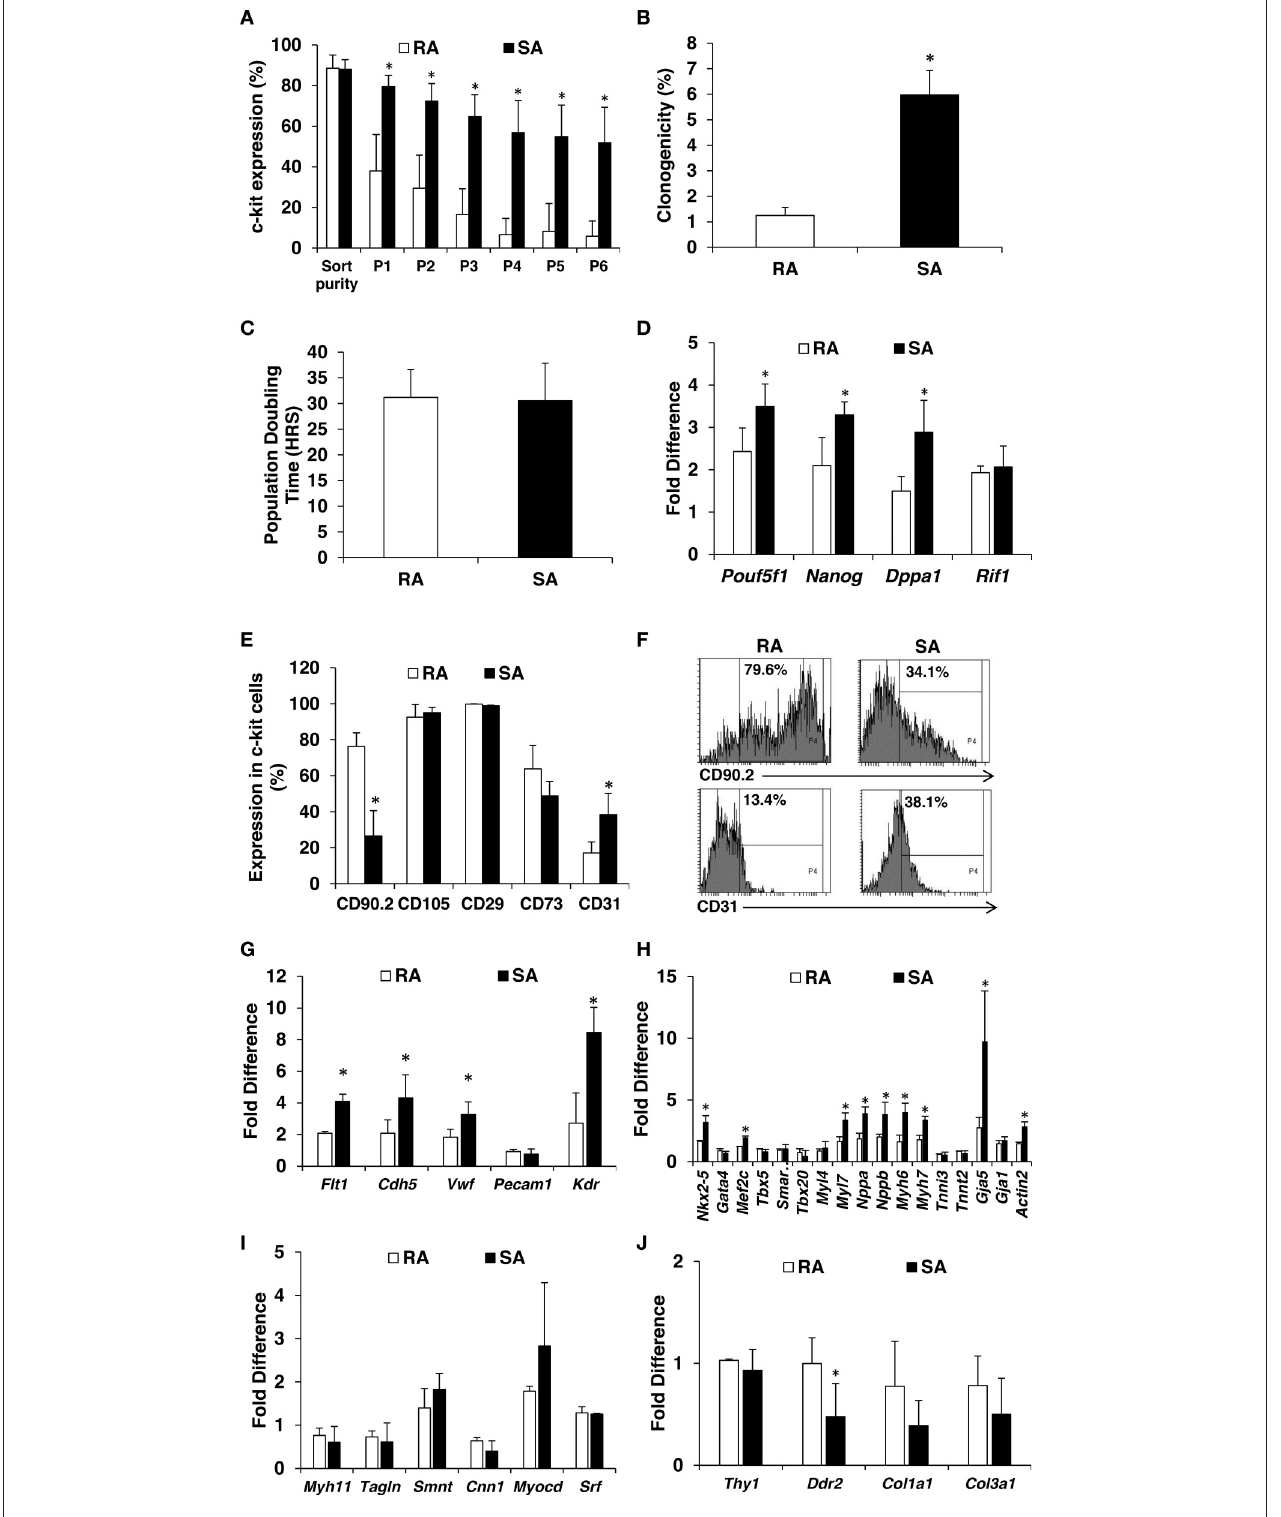
FIGURE 3 | Characterization of RA and SA c-kit pos CMCs. Flow cytometric analysis of c-kit expression in RA and SA c-kit pos CMCs ( n = 3) (A). Clonogenicity performed using Terasaki plates ( n = 4) (B) . Population doubling times ( n = 7) (C). Expression of pluripotency markers by qPCR at mRNA level ( n = 3) (D) . Mesenchymal and endothelial marker analysis by flow cytometry ( n = 2) (E,F) . Expression of endothelial (G) , cardiac (H) , smooth muscle (I) and mesenchymal (J) markers evaluated by qPCR ( n = 3). Values are mean ± SD * p < 0.05 vs. RA.